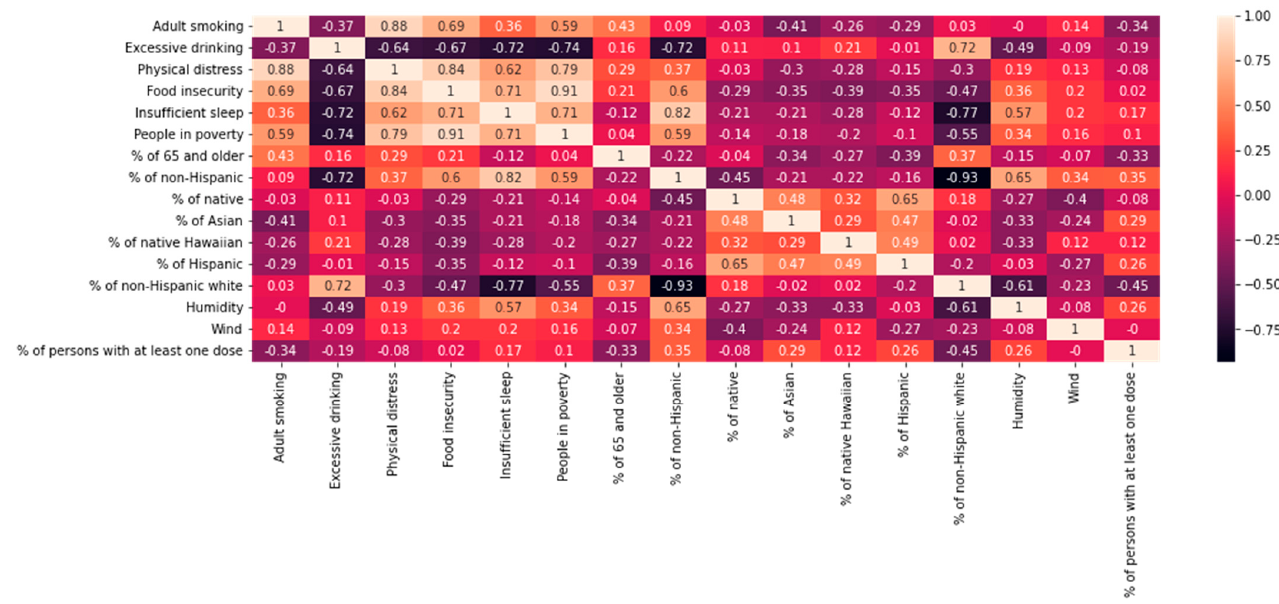
Figure A2. Correlation coefficients among different variables in 2021 DJF after backward selection.